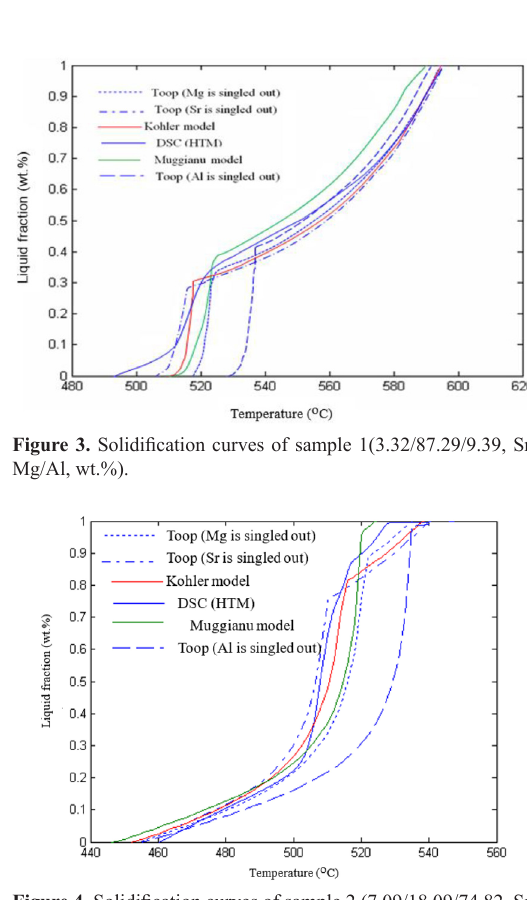
Figure 4. Solidification curves of sample 2 (7.09/18.09/74.82, Sr/ Al/Mg, wt.%).